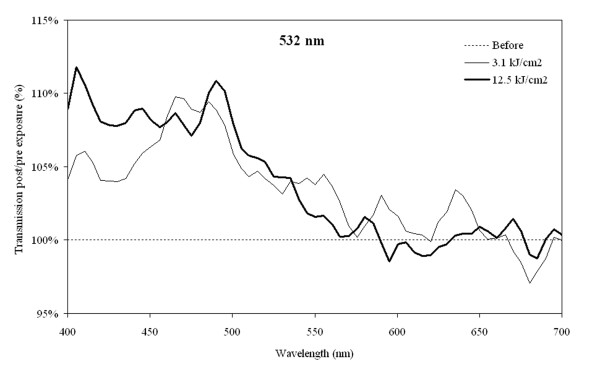
Transmission changes after 532 nm. Changes in transmission of a human donor lens (aged 72 years) during irradiance with a 532 nm continuous wave laser for 10 and 40 minutes. Transmission before irradiation was set to 100% for all wavelengths.